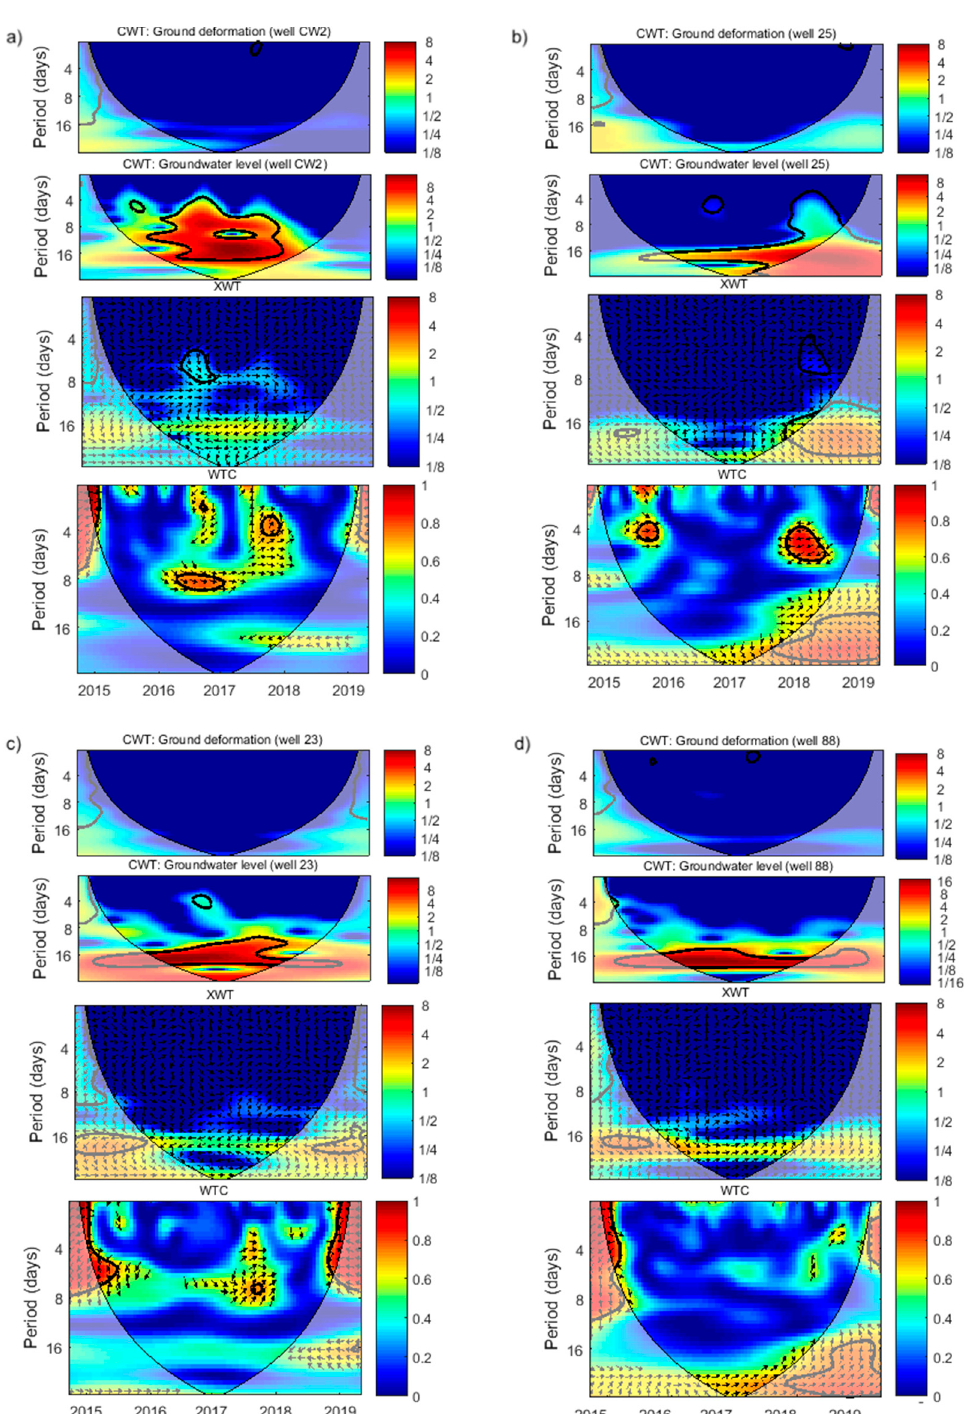
Figure 7. Continuous wavelet power (CWT) scalograms of InSAR-derived ground deformation rates and groundwater level change at well 23; cross-wavelet transform (XWT) of two time series; wavelet coherence (WTC) of two time-series series at four wells: ( a ) well CW2; ( b ) well 25; ( c ) well 23; ( d ) well 88; The thick contour indicates the 95% confidence level. The cone of influence (COI) is illustrated as light shadow.